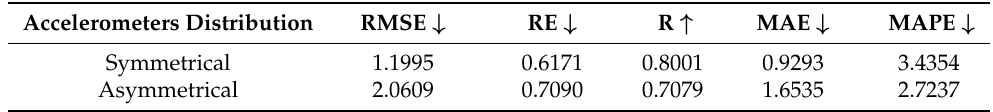
Figure 9. Symmetrically and asymmetrically distributed accelerometers in the experiment. In to- tal, 4 accelerometers are used. To avoid other interferences, only 1 exciter is used in exepriment. ( a ) Symmetrically distributed 4 accelerometers and 1 exciter on the aircraft model. ( b ) Asymmetrically distributed 4 accelerometers and one exciter on the aircraft model. Table 11. Quantitative comparisons on different distribution of sensors.